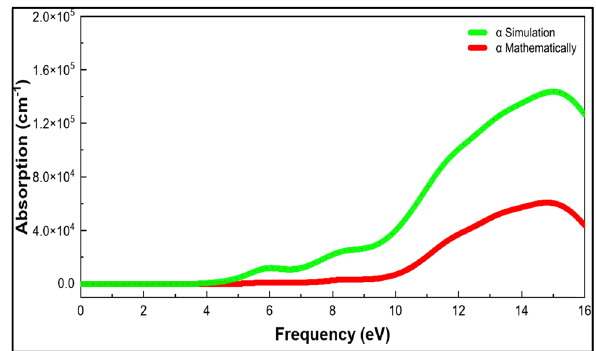
Figure 10: Mathematical and simulation absorption vs frequency of nylon